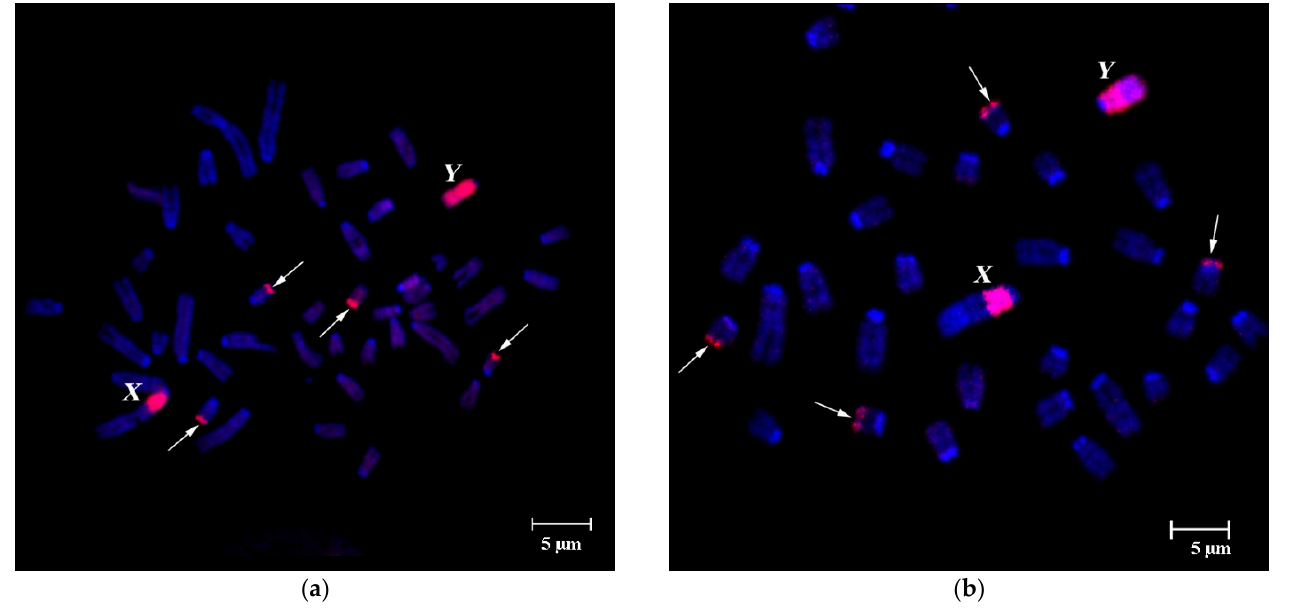
Figure 3. FISH of B-specific Whole Chromosome Paint (WCPB) (red signal) onto metaphases of males without Bs from fibroblast cell culture of A. flavicollis individuals. ( a ) WCP3977B probe (from a specimen from Petnica, Serbia) hybridized onto metaphase plate of specimen #3979 (Orašac, Serbia); ( b ) WCP3980B probe (from a specimen from Orašac, Serbia) hybridized onto metaphase plate of specimen #3978 (Orašac, Serbia). Bs, X and Y-chromosomes are marked by corresponding letters; arrows indicate heterochromatic blocks on four small autosomes. DAPI total chromosome staining is blue. Scale bar 5 µm.